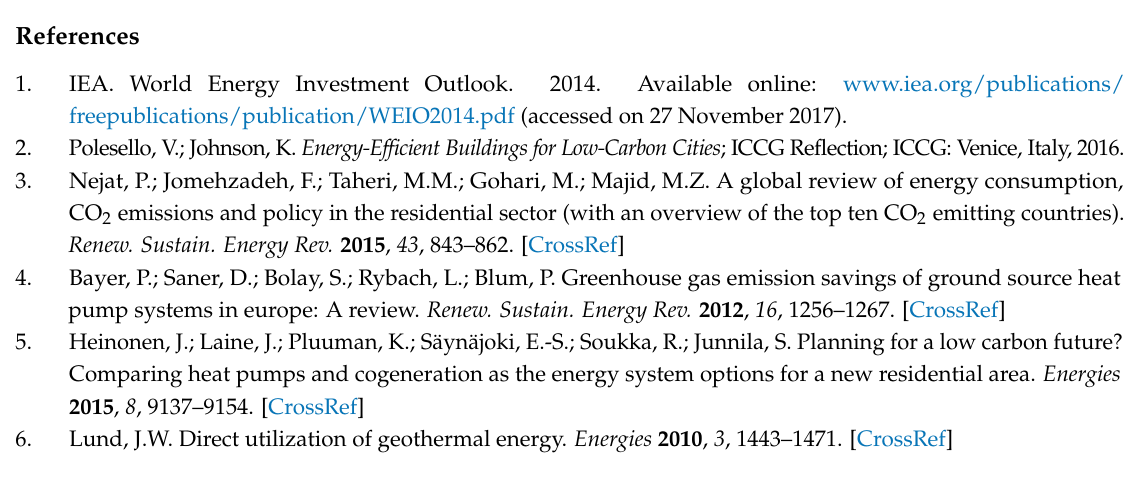
s1: Table S1: Stratigraphy of the external wall in “good insulation” buildings; Table S2: Stratigraphy of the under-roof slab in the “good insulation” buildings; Table S3: Stratigraphy of the roof in the “good insulation” buildings; Table S4: Stratigraphy of the basement slab on cellar in the “good insulation” buildings; Table S5: Stratigraphy of the external wall in the “poor insulation” buildings; Table S6: Stratigraphy of the under-roof slab in the “poor insulation” buildings; Table S7: Stratigraphy of the roof in the “poor insulation” buildings; Table S8: Stratigraphy of the basement slab on cellar in the “poor insulation” buildings; Table S9: Occupancy levels (number of people) in the Hotel during different times at the first floor and upper floors. (WD, Working Days; WE, Weekend days); Table S10: Ventilation flow rates q ve,k,mn expressed as number of air changes (h –1 ) in the Office building.; Table S11: Ventilation flow rates q ve,k,mn expressed as number of air changes (h –1 ) in the Hotel building.; Table S12: Reference temperatures for design heating load in different climate zones; Table S13: Borehole heat exchangers and ground properties [7,8]; Table S14: Borehole total length for the different building and climates calculated with the ASHRAE method [9]; Table S15: Cost curve in Euro for different components related to specific capacities. A linear cost was supposed for the Borehole Heat Exchanger (BHE). (DHW: Domestic Hot Water, ACS: Air Conditioning System); Table S16: Electricity CO 2 emission factors according to JRC (2017, [15]), calculated with two methods (standard and LCA), and the respective minimum and maximum CO 2 emission reductions achieved in the 36 simulated cases. Figure S1: Specific heating demand for highly-insulated (A) and poorly-insulated (B) buildings, specific cooling demand for highly-insulated (C) and poorly-insulated (D) buildings; Figure S2: Full Load Equivalent Hours (FLEH) of heat pump operation for highly-insulated (A) and poorly-insulated (B) buildings in heating conditions, FLEH for highly-insulated (C) and poorly-insulated (D) buildings in cooling conditions.; Figure S3: Share of Domestic Hot Water (DHW) demand over the total energy demand for the different building cases in heating (A) and cooling (B) conditions.; Figure S4: Incidence of BHE costs on the total cost of a GCHP; Figure S5: Discounted Payback Period (DPP) compared with the electricity/fuel price ratio for the brand new highly-insulated buildings in climate Zone E (A), Net Present Value (NPV) compared with the electricity/fuel price ratio for the brand new highly-insulated buildings (B) and refurbished poorly-insulated building (C) in climate Zone E.; Figure S6: CO 2 reduction achieved for the 36 simulated cases, using electricity from the grid with a low (France, 93 g CO 2 /kWh, in green), an average (Italy, 424 g CO 2 /kWh, in blue) and a high (Poland, 1090 g CO 2 /kWh, in red) CO 2 emission factor. (Hou, House; Off, Office; Hot, Hotel; g, good insulation; p, poor insulation; A, B, C, D, E, and F, the climate zones according to Table 2 of the main